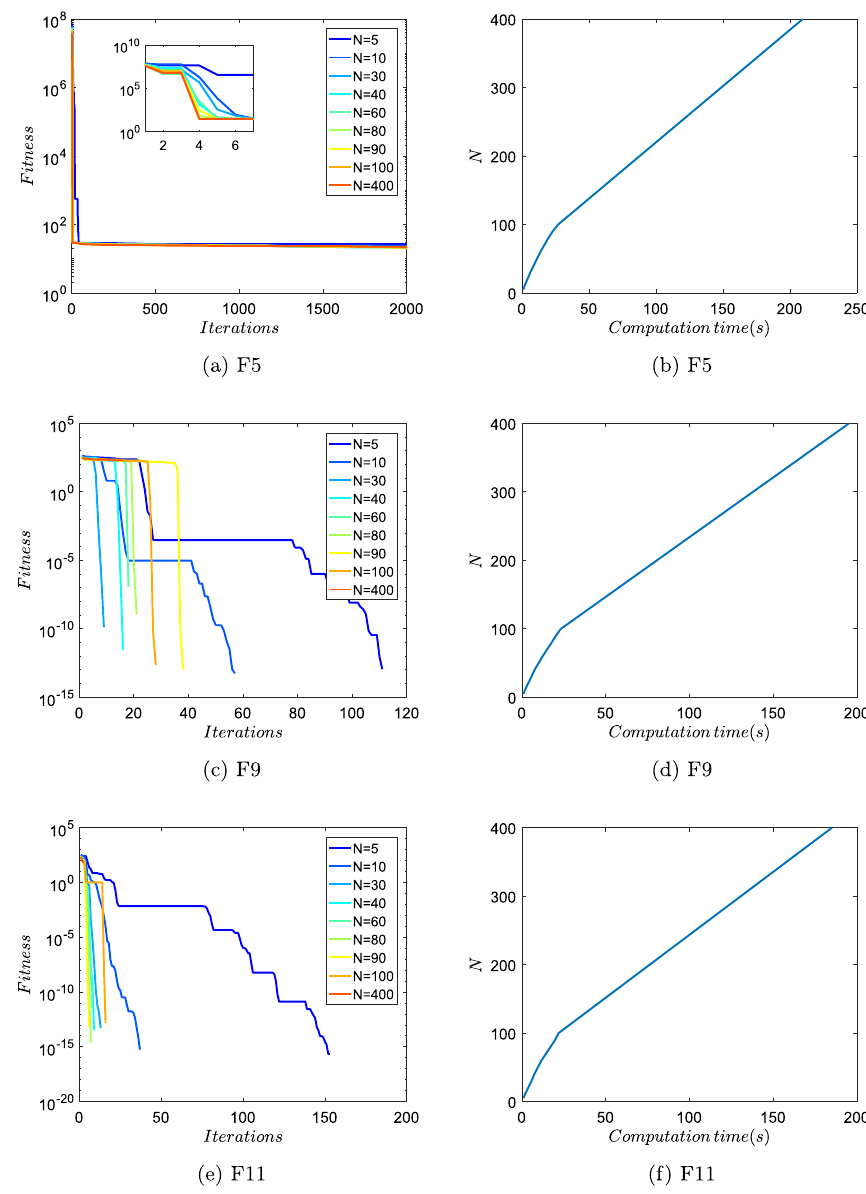
Fig. 12 Fitness performance (a, c, e) and time complexity (b, d, f) of PSO-TPME on 30-dimen- sional functions F5, F9 and F11 with different number of